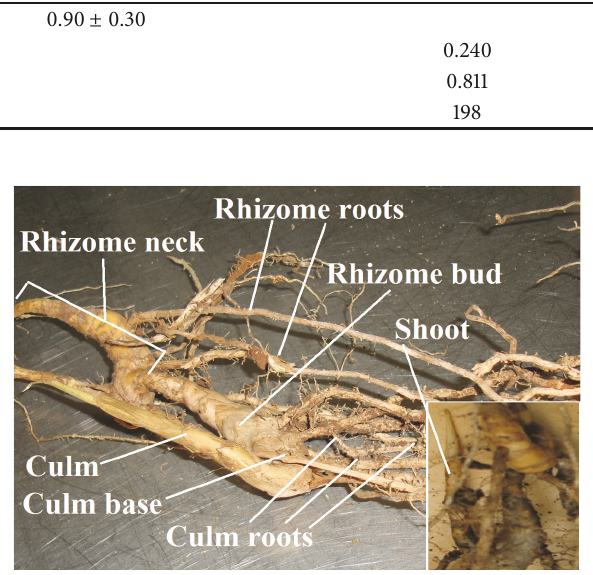
Figure 1: Short-necked pachymorph rhizome type of O. abyssinica seedlings at CEE-FRC ( source: photo taken by Tinsae Bahru